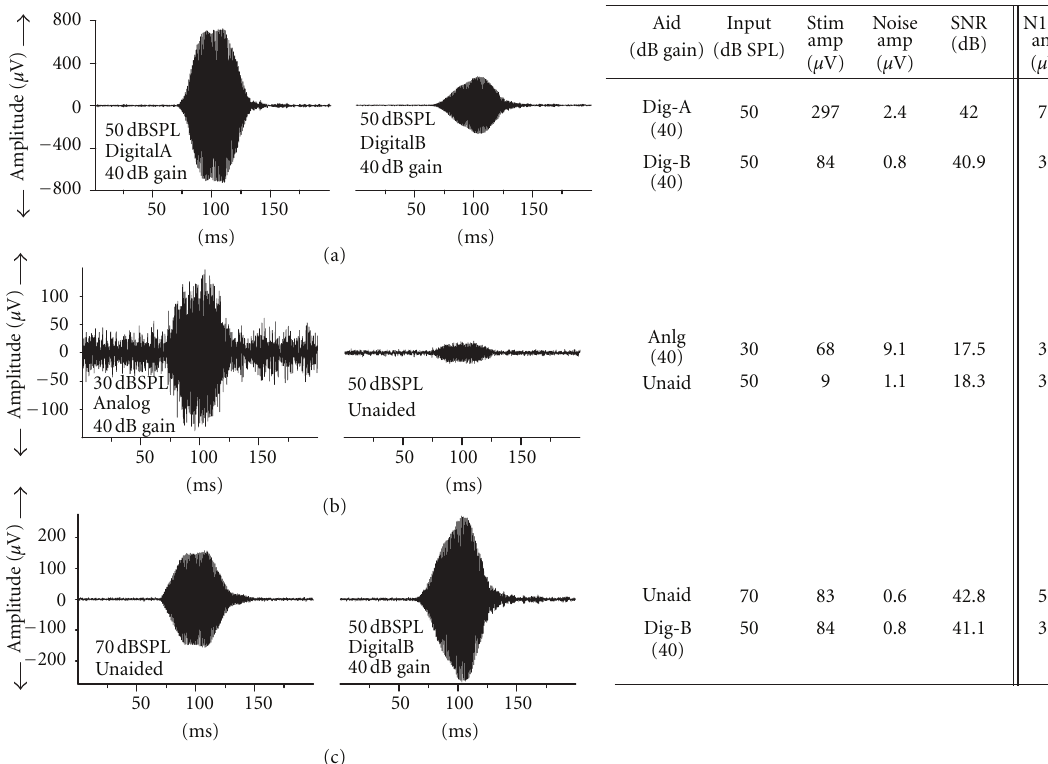
Figure 8: Three examples measured for one participant to show the relationship between stimulus level, SNR, and SCP amplitude. (a): stimulus level predicts SCP amplitude; (b): SNR predicts SCP amplitude; (c): neither stimulus level nor SNR predict SCP